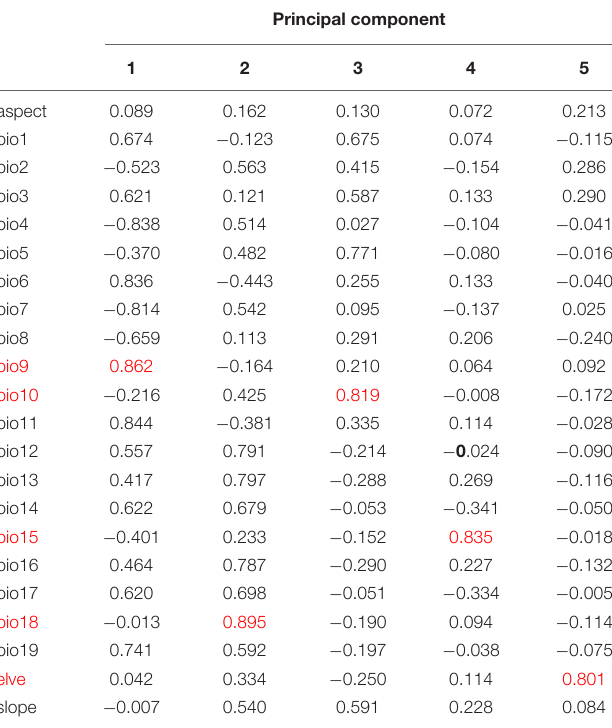
TABLE 1 | Component matrix of CPB. TABLE 2 | Component matrix of P.